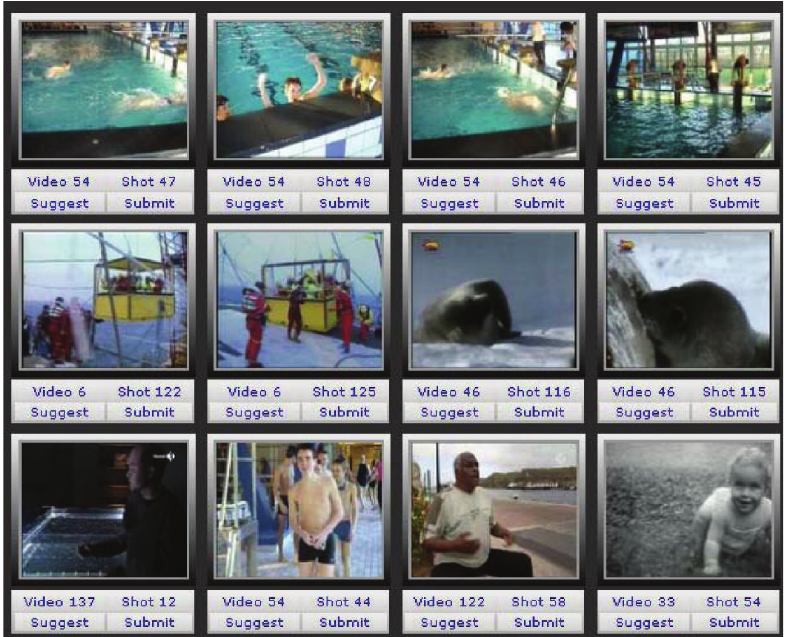
Figure 10: Results from a textual query (keyword “water”) searching with the aid of the weighted